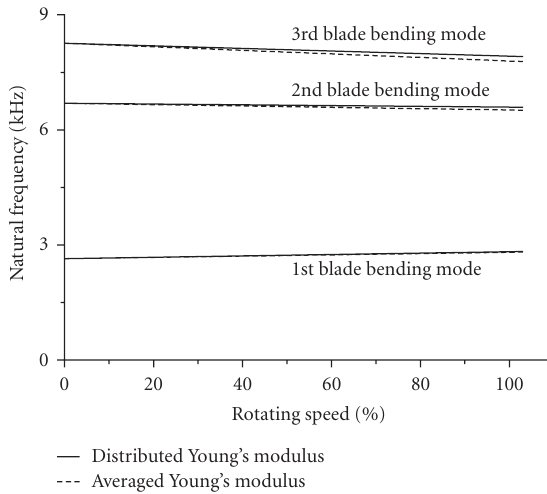
Figure 7: Campbell’s diagram of the three lowest bending modes of a blade, considering both centrifugal e ff ect and temperature e ff ect (100% in the horizontal axis means the rated rotating